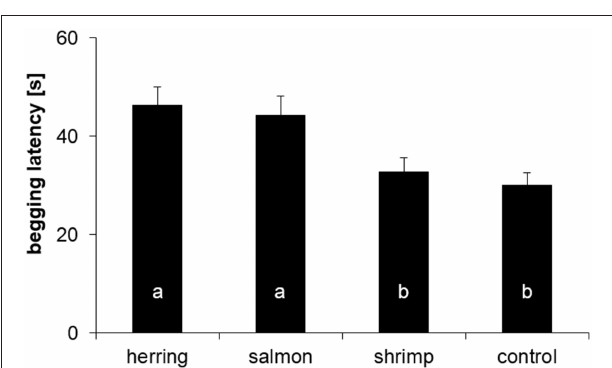
FIGURE 4 | Mean ( ± SE) latency [s] of the dolphins to come back and beg for a new ice cube after receiving a herring, salmon, shrimp, or control ice cube. Same letters indicate absence of statistical difference ( α = 0.05